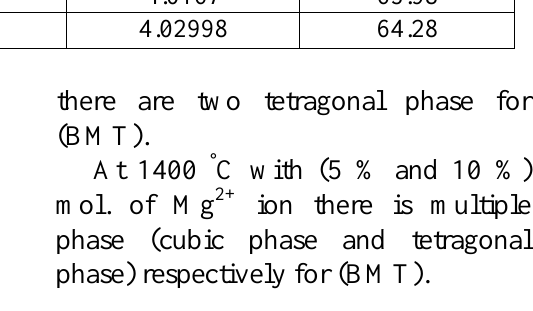
(BT) in angstrom. 3